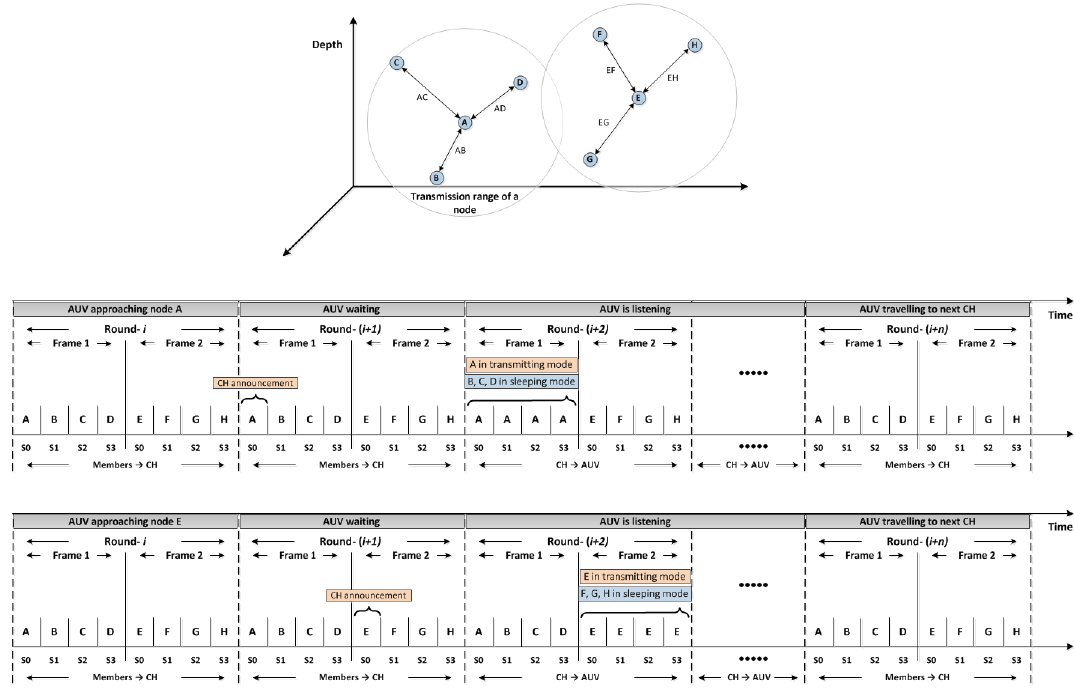
Figure 3. Timeline of our cross-layer proposed